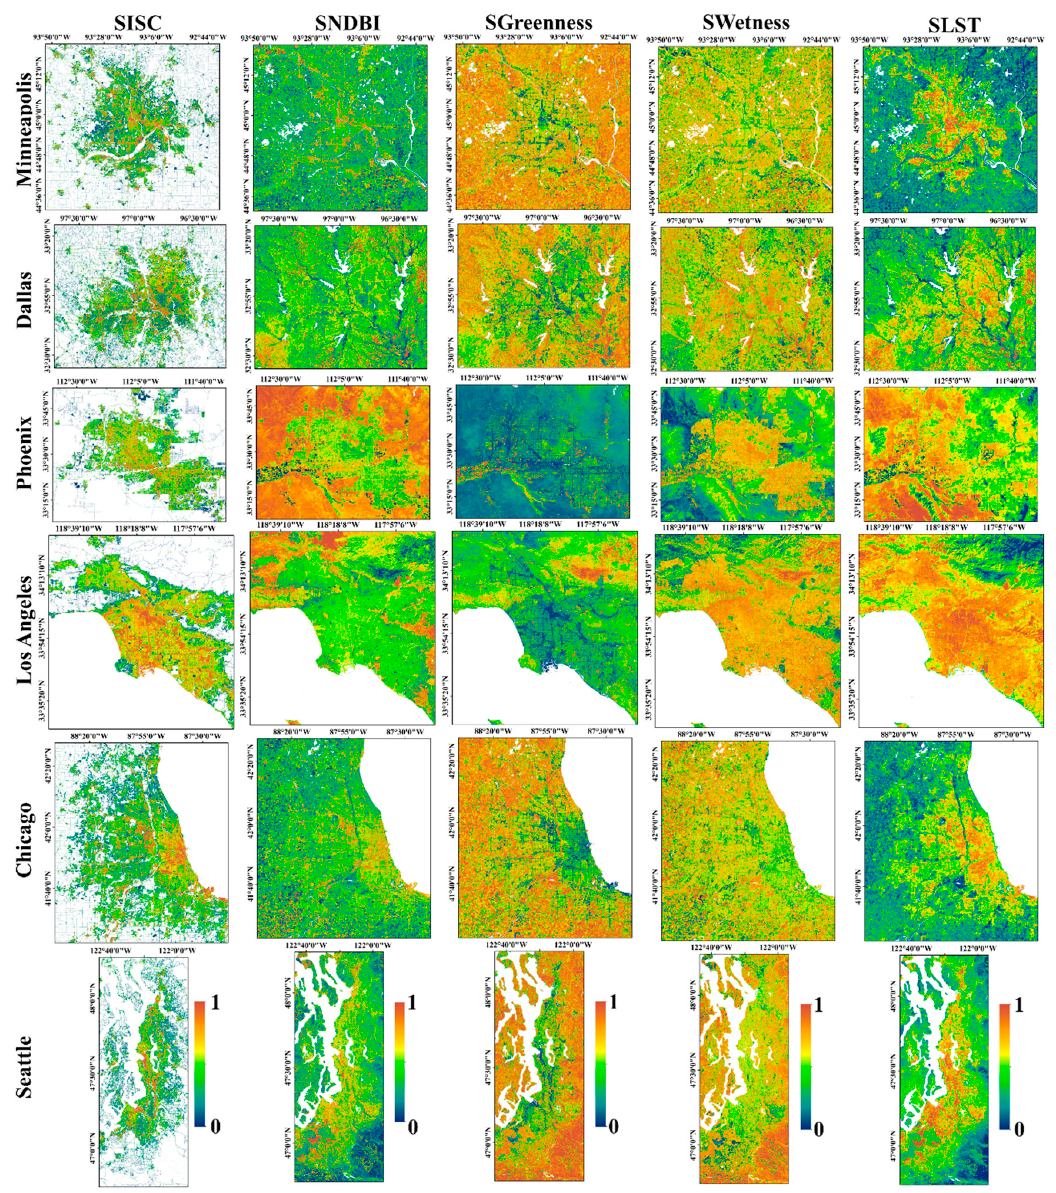
Figure 4. The mean of standardized ISC (SISC), standardized normalized difference built-up index (SNDBI), standardized greenness (SGreeness), standardized wetness (SWetness), and standardized LST (SLST) maps for the selected cities in USA on different dates.